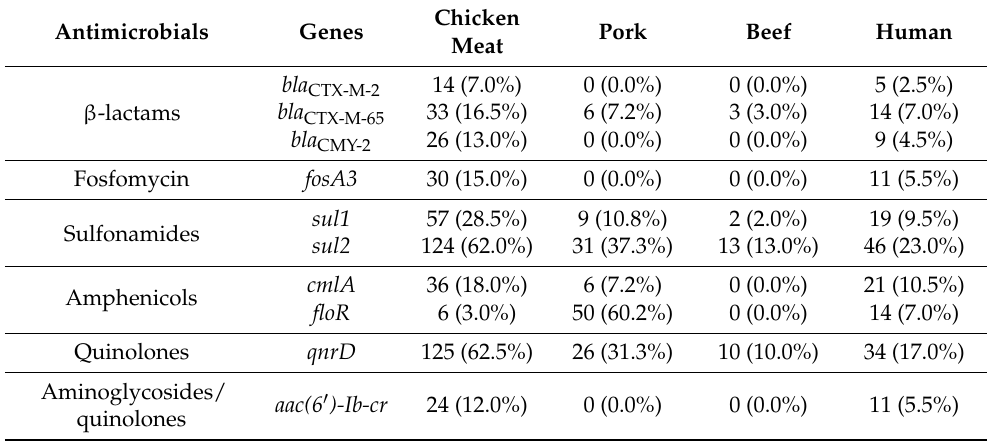
Table 1. Prevalence of resistance genes detected in P. mirabilis isolated from chicken ( n = 200), pork ( n = 83), beef ( n = 100), and UTI-CA ( n =